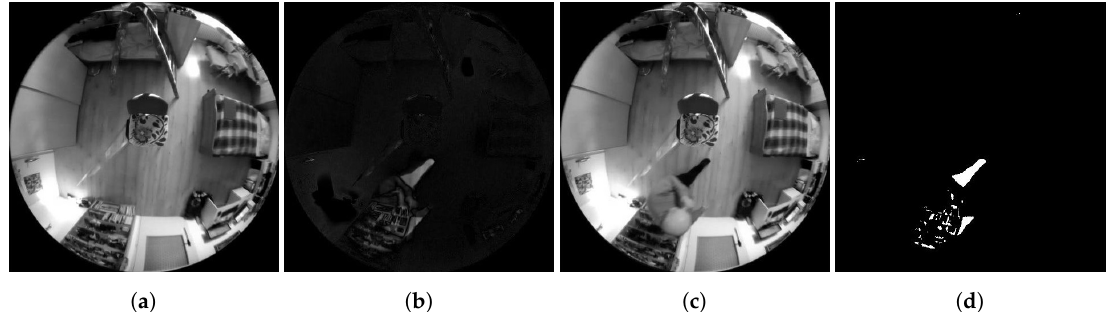
Figure 8. Examples of Method 1.3 functionality. ( a ) Background frame. ( b ) Difference in brightness between the currently checked frame and the background frame. ( c ) Currently checked frame.